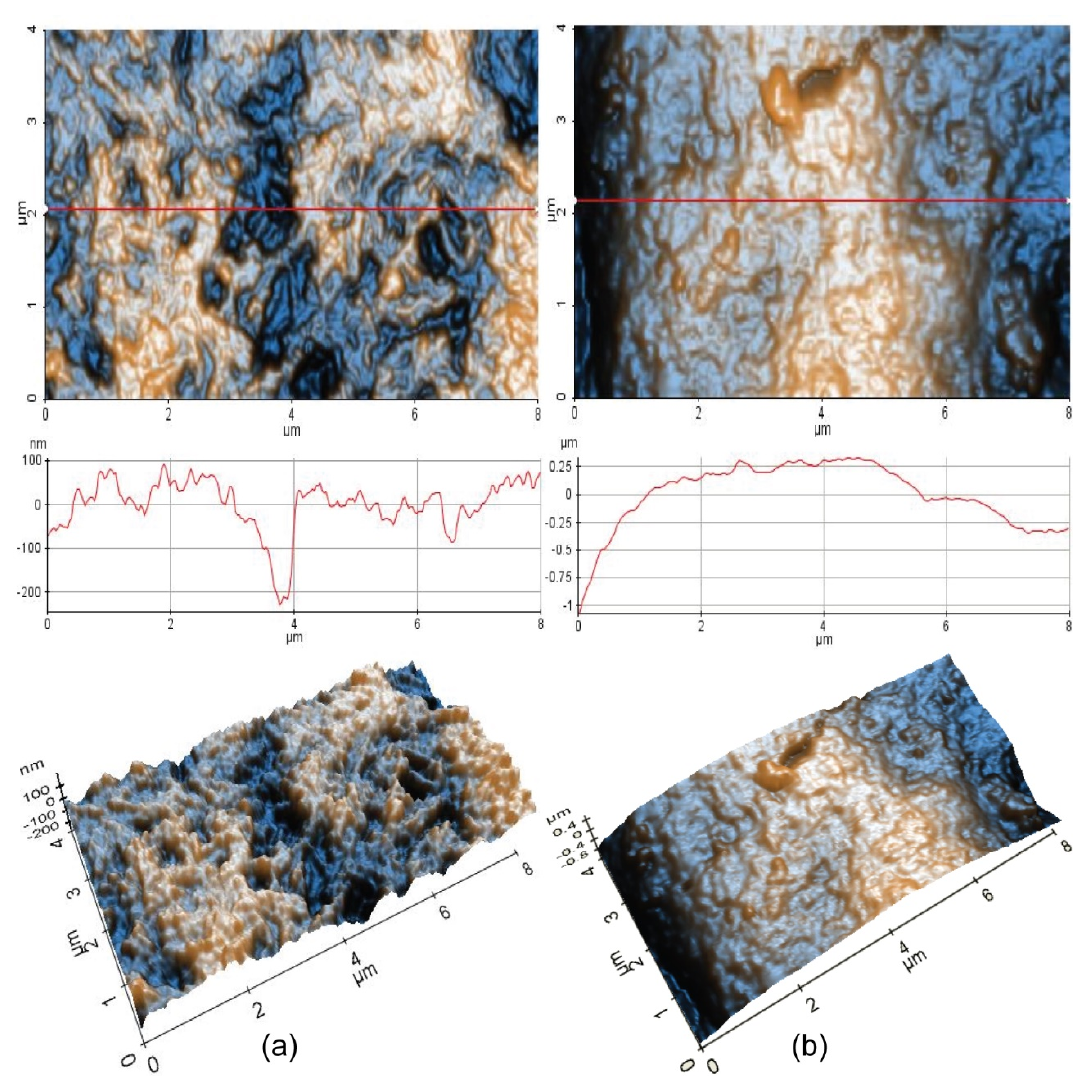
Figure 9. The 2D and 3D AFM topographic images of Sample 1 ( a ) and Sample 2 ( b ) at the scan area of (4 μm × 8 μm); representative line scans are shown, collected at the position indicated by a horizontal red-line in the 2D AFM images.